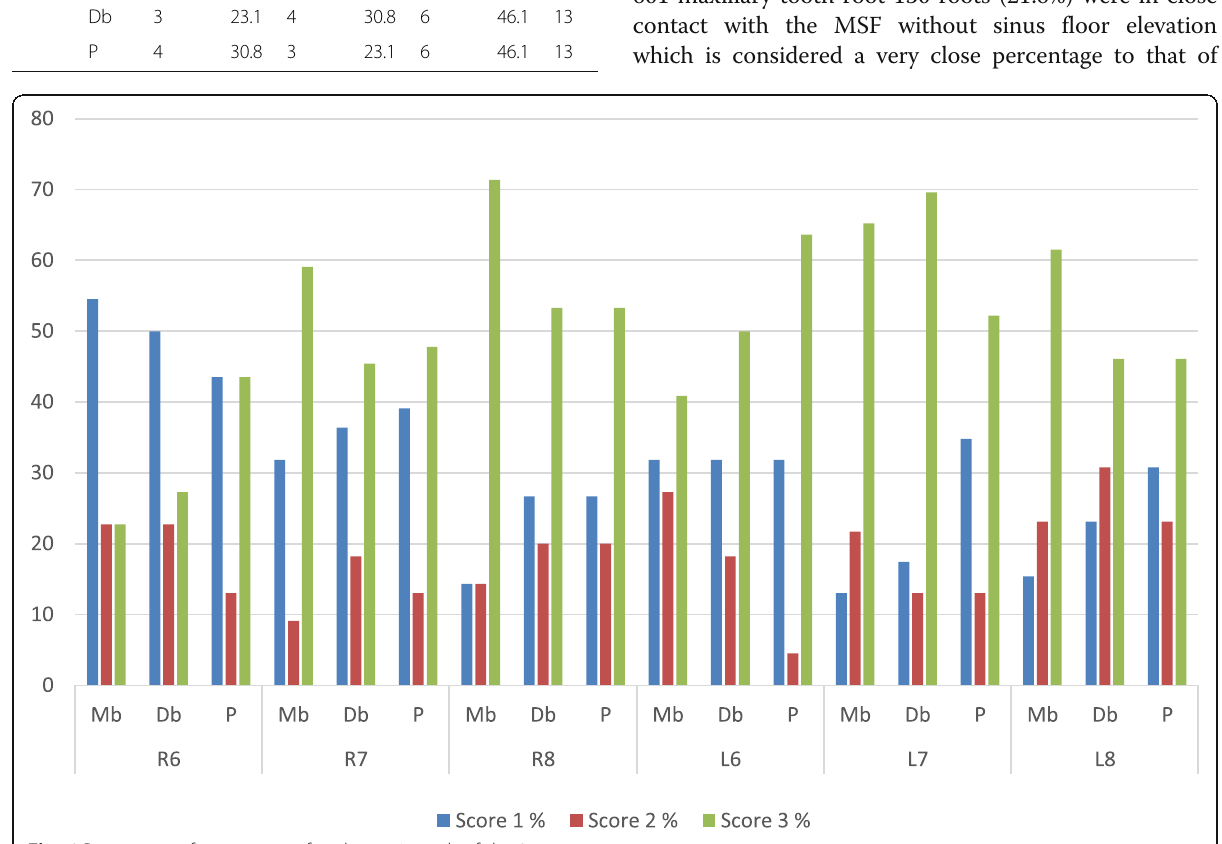
Fig. 6 Percentage of occurrence of each root in each of the 3